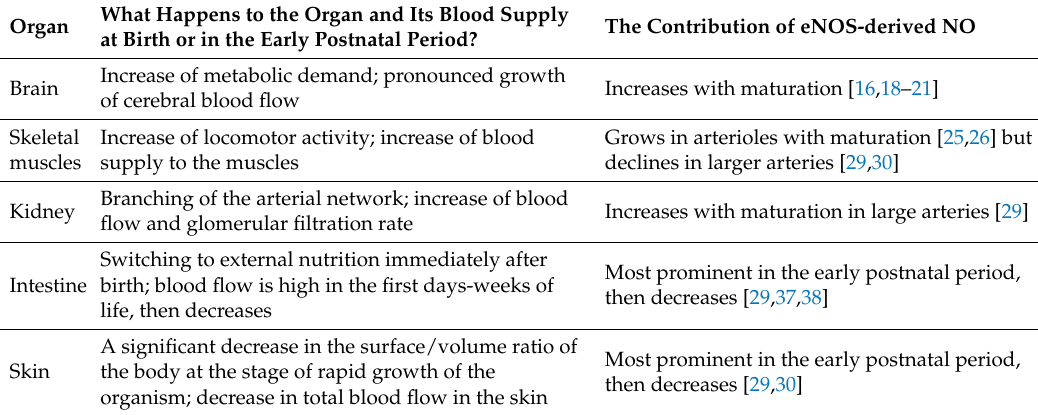
Table 1. Organ-specific changes in the contribution of endothelial NO-synthase (eNOS)-derived NO to the regulation of vascular tone during early